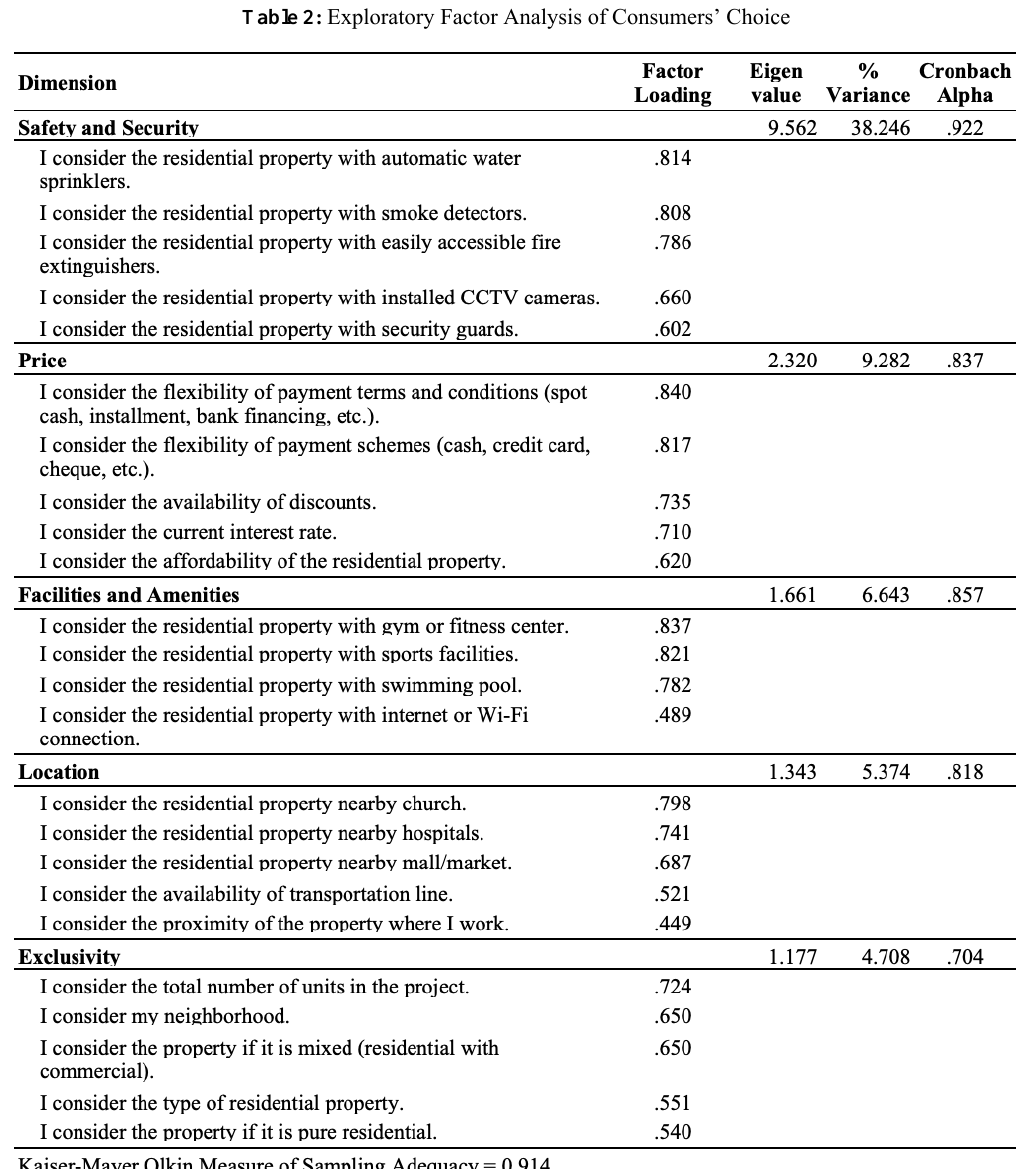
Table 2: Exploratory Factor Analysis of Consumers’